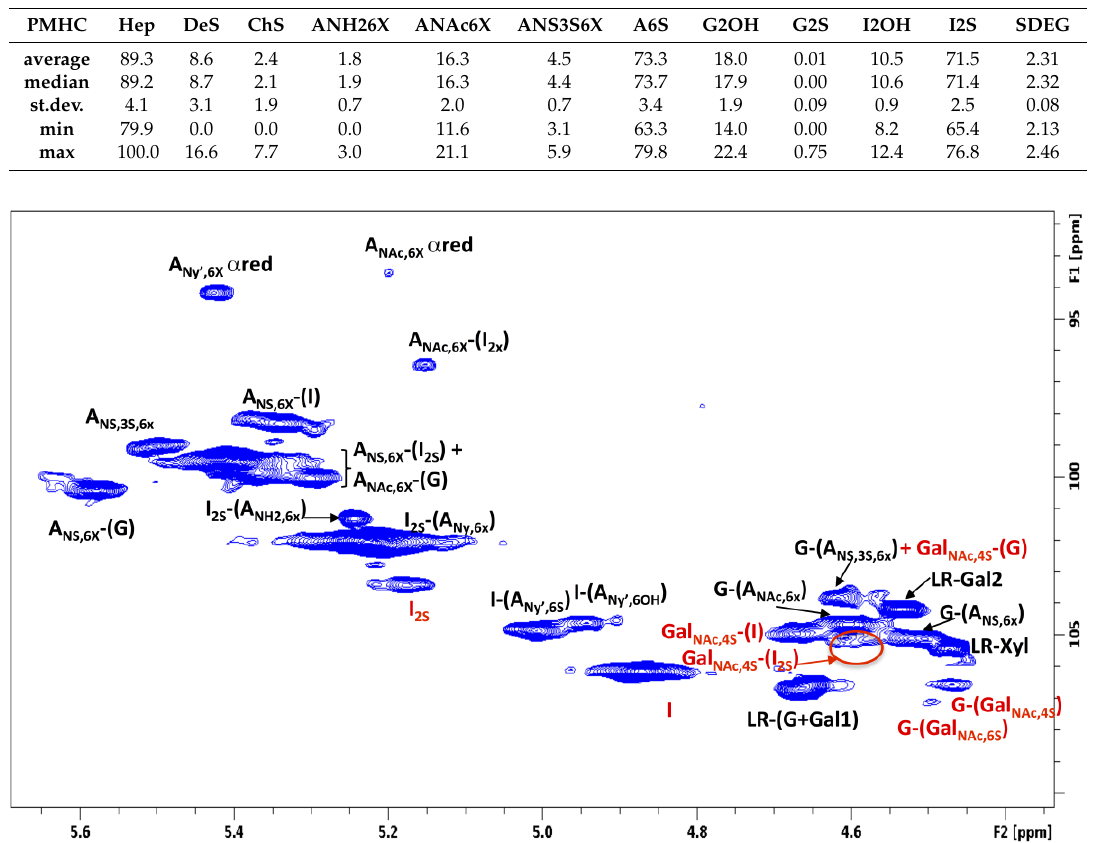
Table 2. Molar average composition of 88 crude heparin samples. PMHC = pig mucosa heparin crude; Hep = Heparin; DeS = Dermatan sulfate; ChS = Chondroitin sulfate; A = Glucosamine; I = Iduronic acid; G = Glucuronic acid; X = SO 3 − or H; SDEG = Heparin disaccharide degree of sulfation.